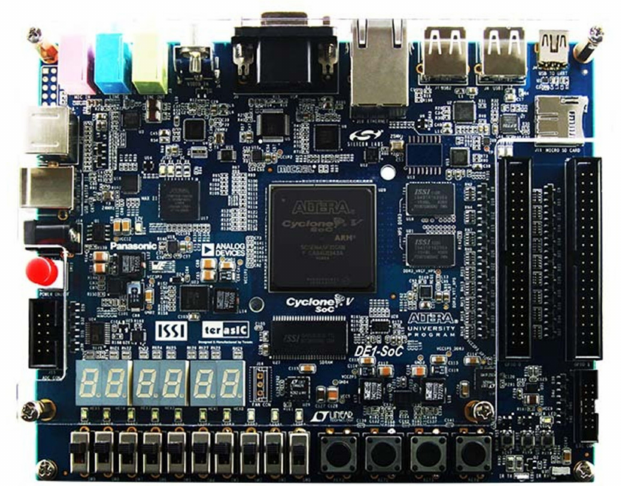
Figure 11. DE1-SoC Development Kit (Top view)